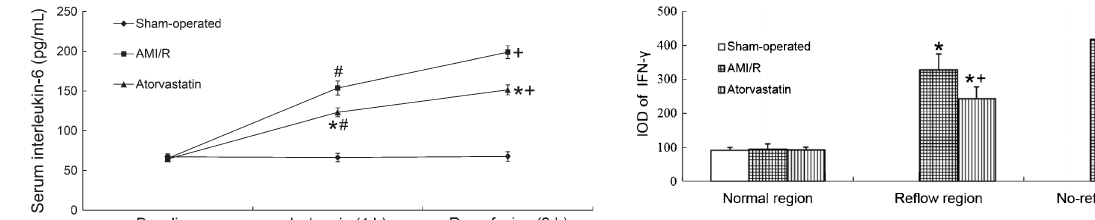
Figure 3. Effects of atorvastatin on serum interleukin-6 at different time points. *P , 0.01, compared to acute myocardial infarction and reperfusion (AMI/R); # P , 0.01, compared to baseline; + P , 0.01, compared to ischemia (4 h) (repeated measures ANOVA followed by the Student-Newman-Keuls test).